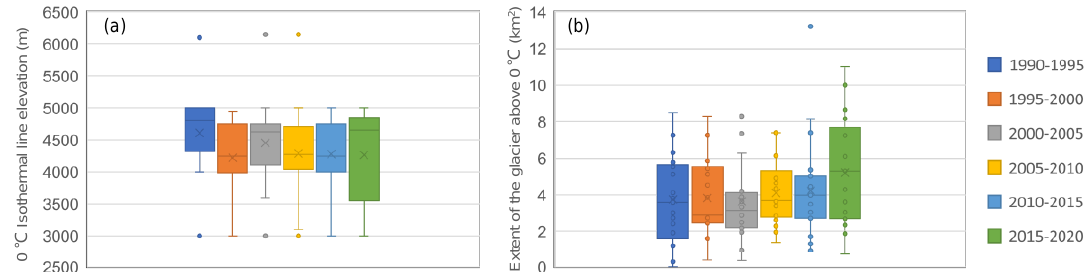
Figure 8. ( a ) Comparison between the station-recorded air temperature and satellite-derived glacier surface temperature. ( b ) Statistics by box plots for the 5-year interval between 1990 and 2018 of station-recorded air temperatures and satellite-derived surface temperatures for the glacier-wide mean and debris-covered area. The dotted white lines indicate variation of means for each 5-year interval.